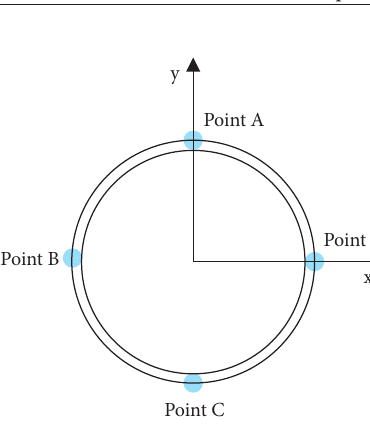
Figure 27: Layout of observation points in numerical simulation.